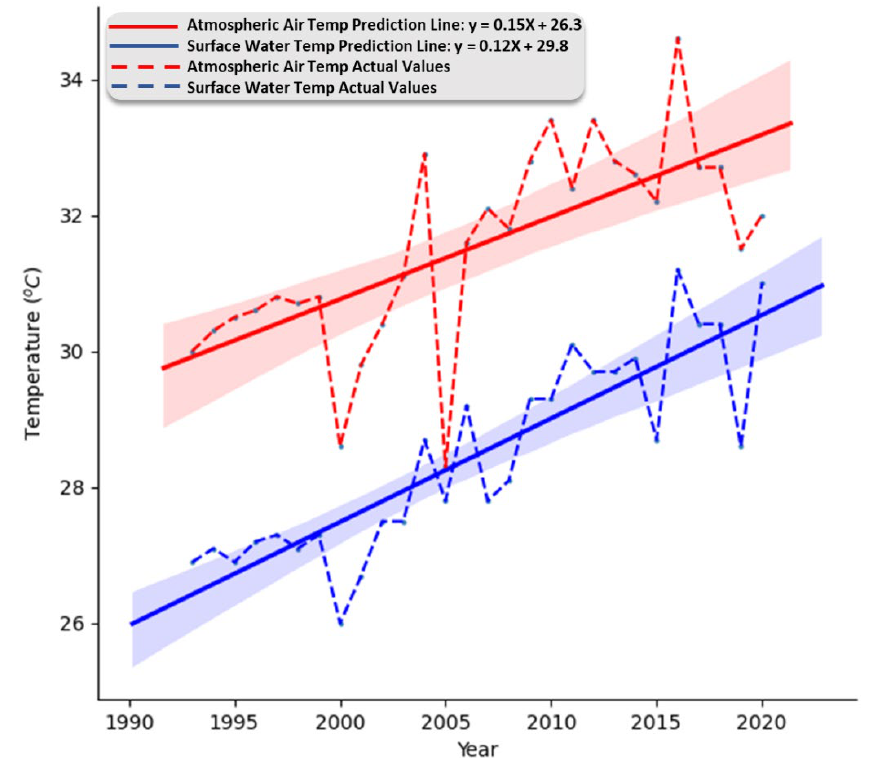
Figure 6. Trends in annual atmospheric and surface water temperatures recorded by the Mundan microclimate weather station and the Taiwan EPA, respectively, 1993–2021.